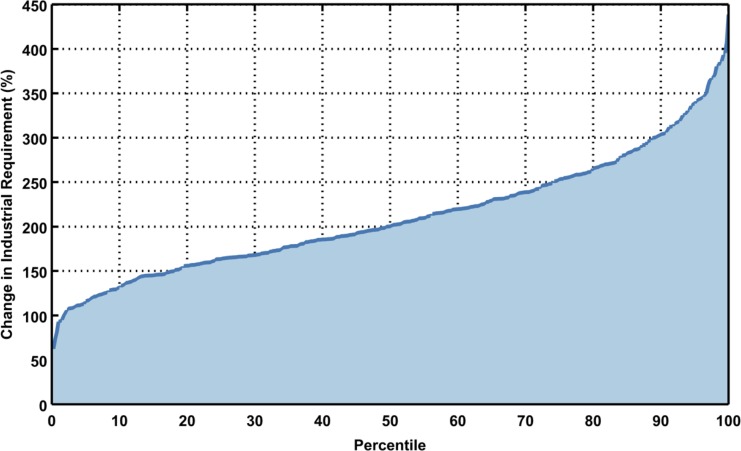
Mean change in industrial requirement for the region for all scenarios.Each point in the line represents one of 400 growth scenarios. Percent change for each ASR in each scenario is weighted by population.